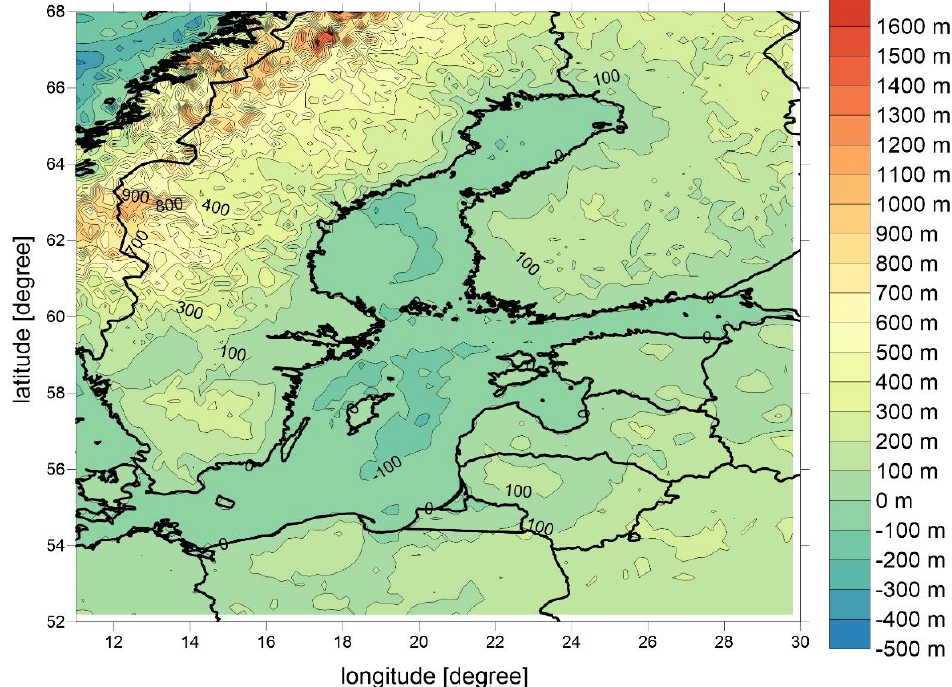
Figure 3. SRTM30 topography model in meters for the area of the Baltic sea and surrounding